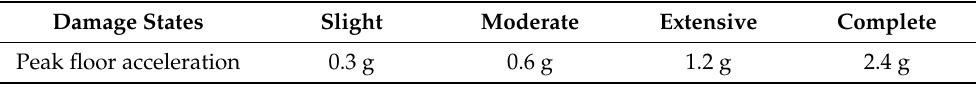
Table 9. Damage states for nonstructural acceleration-sensitive components. Damage States